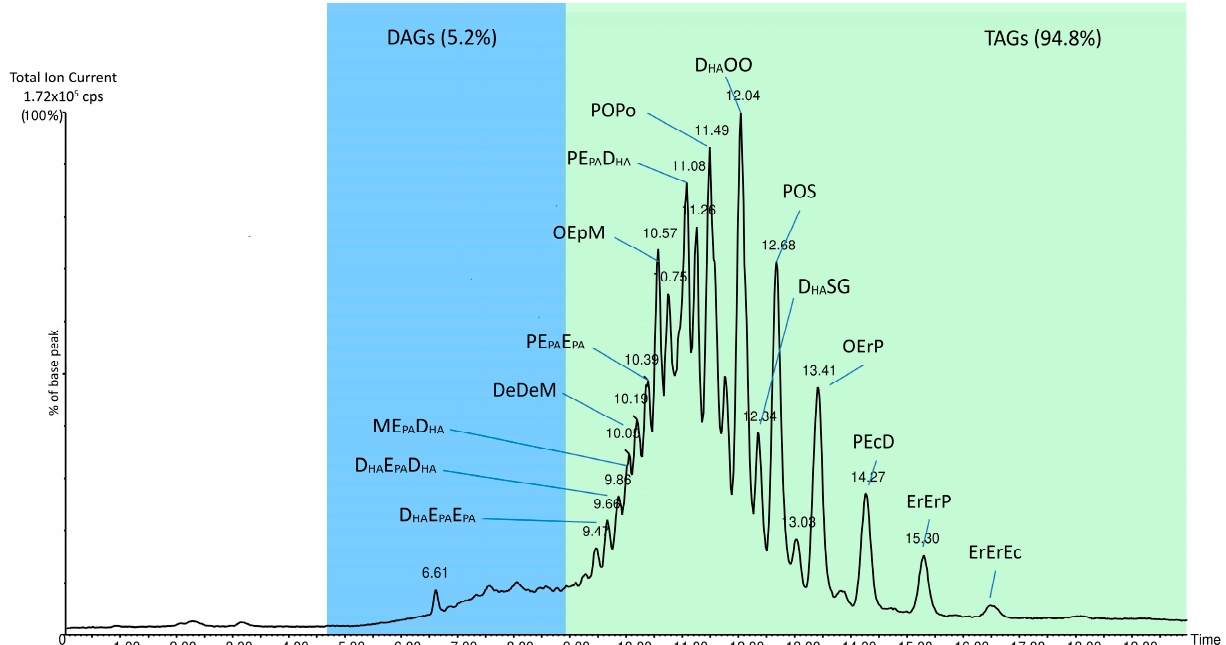
Figure 1. Total ion current HPLC/MS trace of the tuna fish oil. L = linoleic acid, P = palmitic acid, Po = palmitoleic acid, O = oleic acid, S = stearic acid, Ec = eicosaenoic acid, E PA = eicosapentaenoic acid, M = myristic acid, D HA = docosahexaenoic acid; Er = erucic acid.